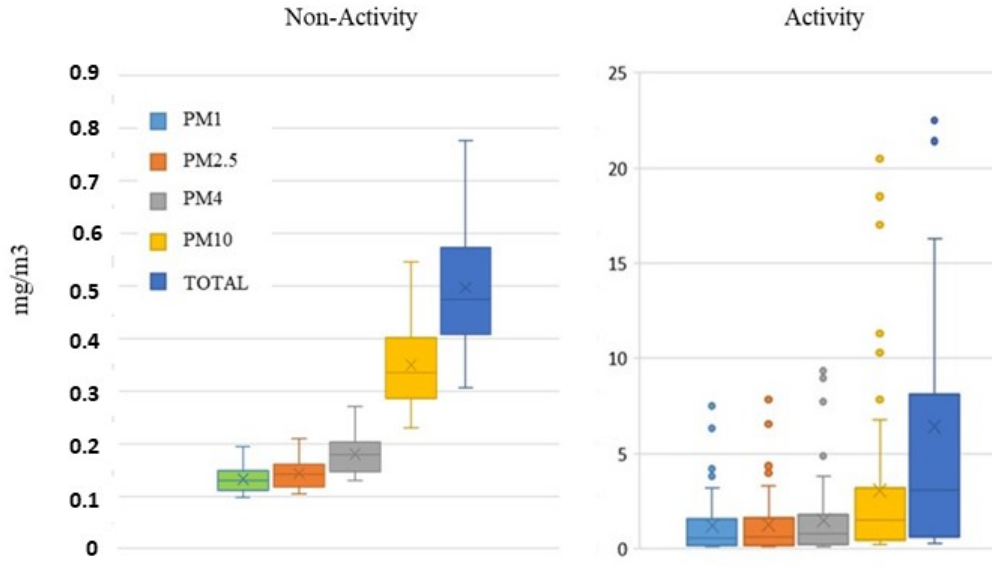
Figure 5. Boxplot of PM levels during the accidental event and non-activity periods. As can be seen from the experimental data reported, the levels of particles measured